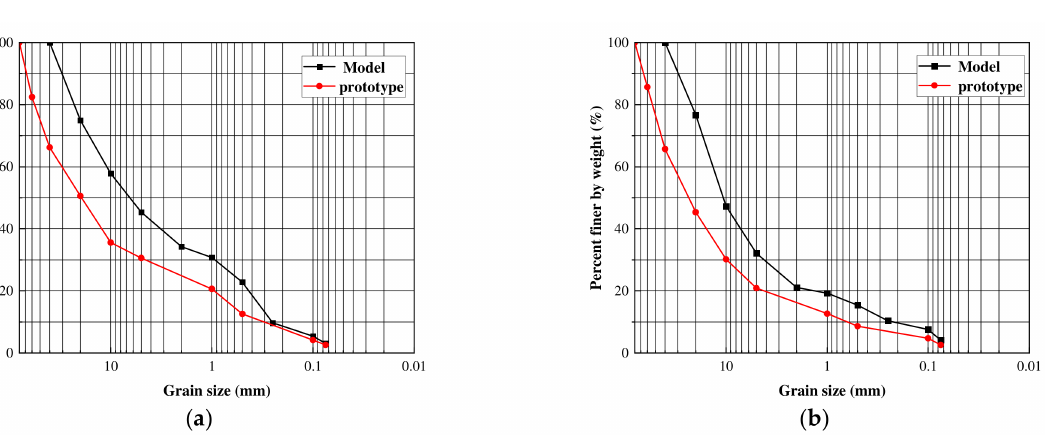
Figure 4. Particle size curves of prototype of accumulation layers and model materials. ( a ) Material 1; ( b ) Material